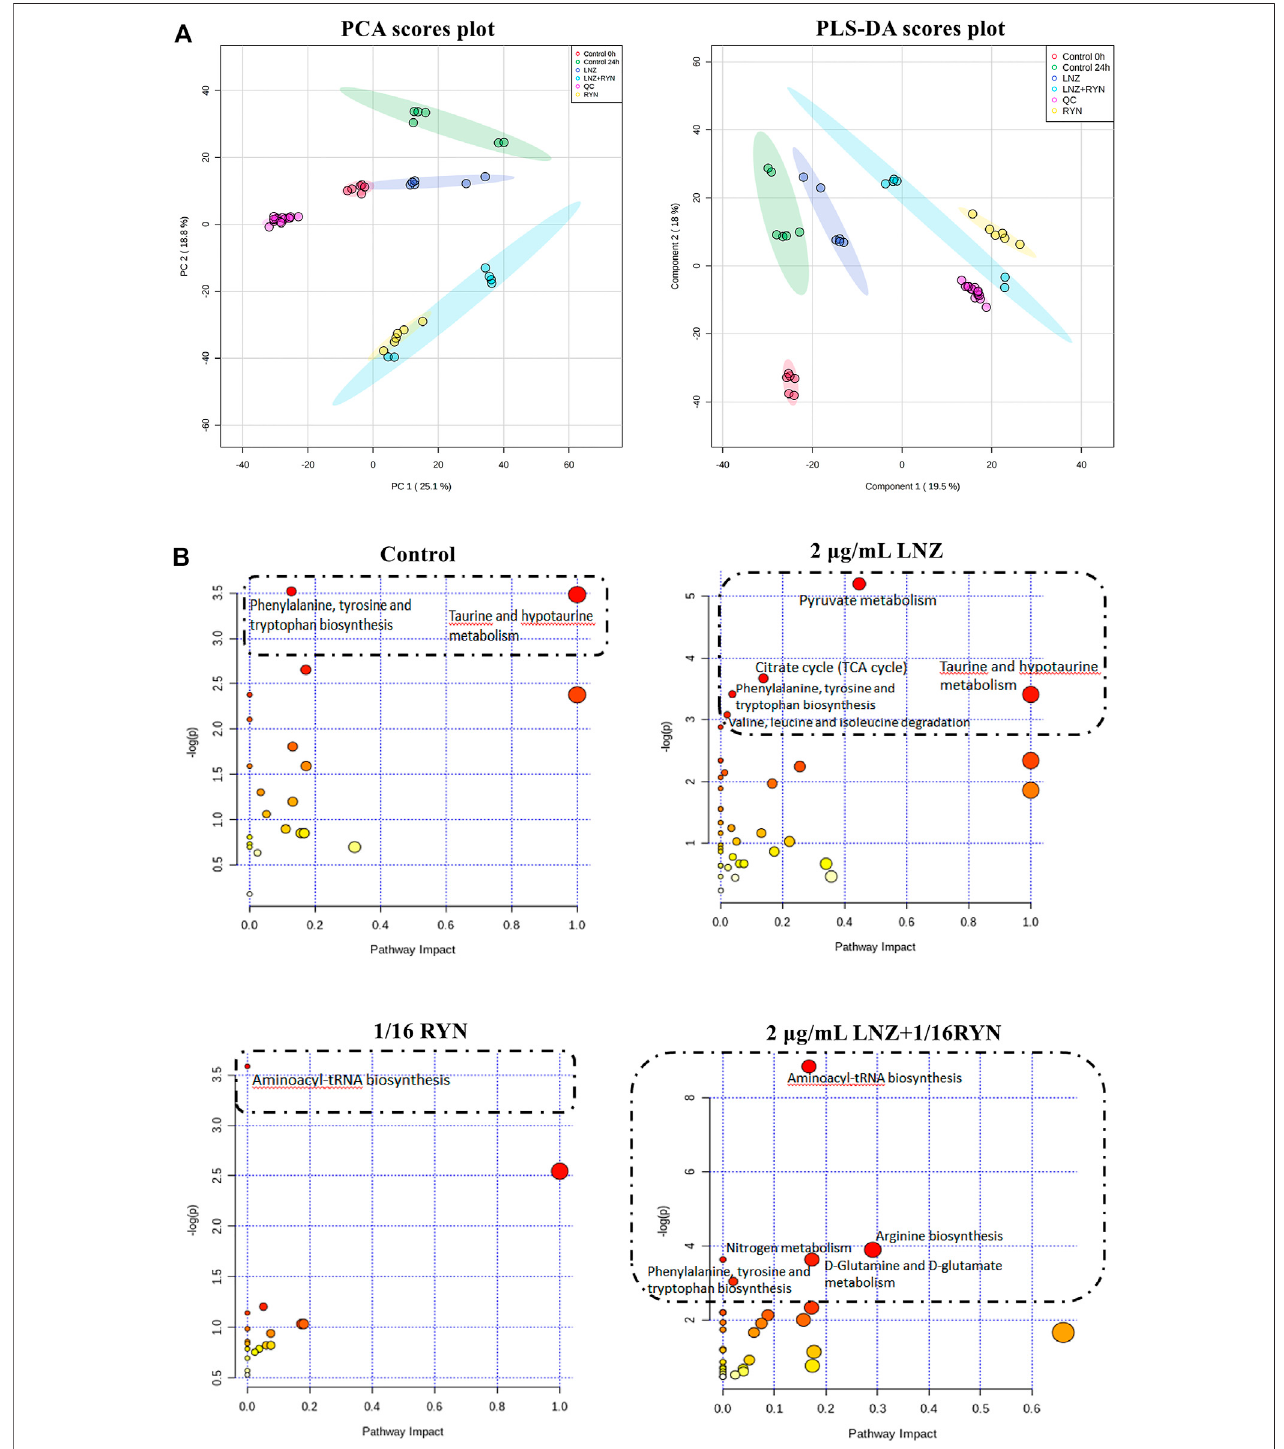
FIGURE5| PCAandPLS-DAscoreplotsandoverviewofpathway analysismetabolites. (A) PCAand PLS-DAscoreplots.PCA scoreplotofallsamplesincluding QC samples. PLS-DA score plot of all samples including QC samples. (B) overview of pathway analysis metabolites. The bubble chart of pathway enrichment analysis showsallmatchedpathwaysaccordingtothepathimpactvalues( X -axis)oftopologicalanalysisand p value( Y -axis)ofpathenrichmentanalysis.Eachnoderepresentsa biological pathway. Bubble area (radius) isproportional to the impact value of each pathway, with the colour denoting the signi fi cance from highest in red tolowest in white. The nodes in the dashed box represent the biological pathways that are signi fi cantly related to bio fi lm markers.